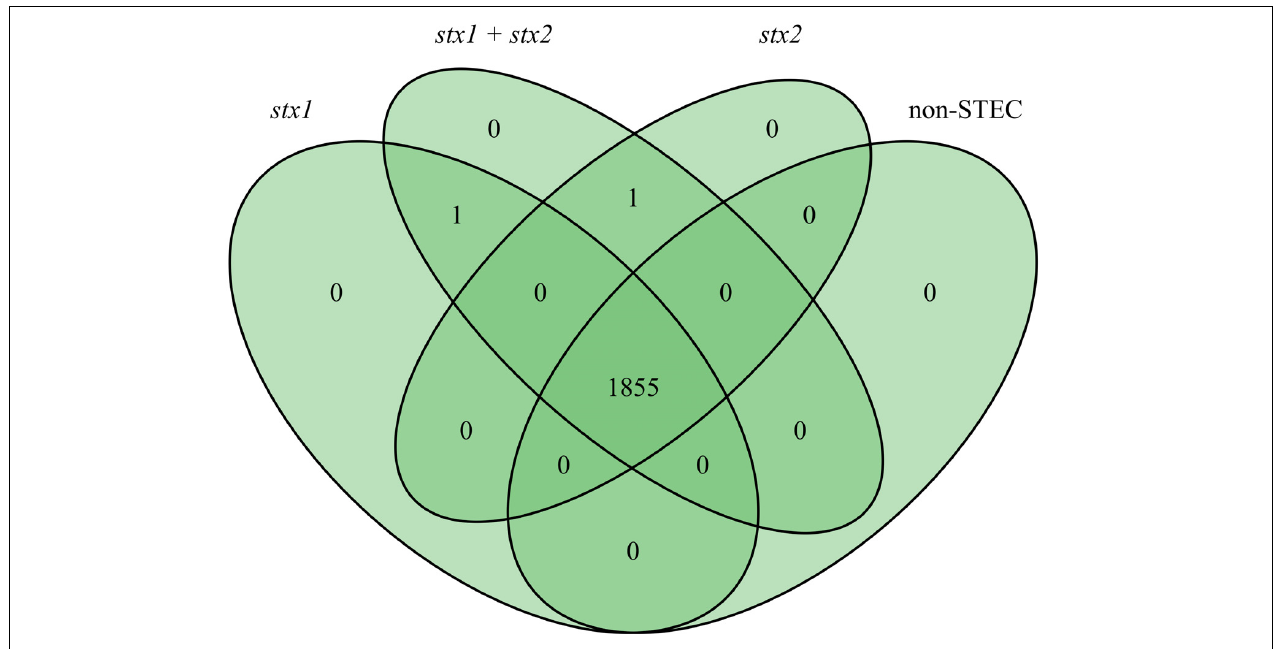
FIGURE 2 | Venn diagram result at checkpoint 1 of bioinformatics pipeline A of 128 genomes grouped into stx 1-positive STEC (25 genomes), stx 1+ stx 2 positive STEC (27 genomes), stx 2 positive STEC (43 genomes) and non-STEC (33